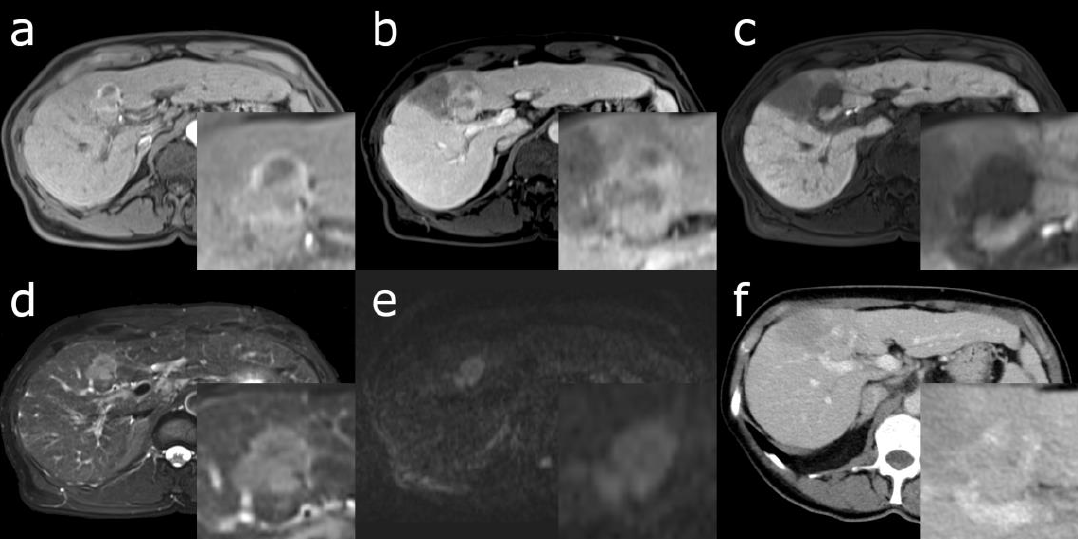
Figure 1. 52-year-old female with liver cirrhosis secondary to chronic hepatitis C infection, Child- Pugh grade A. Axial Gd-EOB enhanced MRI of a singular cHCC-CCA in segment IVa with predom- inant HCC histopathology and macrovascular invasion. ( a ) Rim arterial phase hyperenhancement; ( b ) “washout” in portal venous phase with adjacent parenchymal perfusion deficits; ( c ) homogenous Gd-EOB uptake deficiency in hepatobiliary phase; ( d ) hyperintensity and nodule-in-nodule appearance in a T2-weighted image with fat saturation; ( e ) homogenous diffusion restriction in diffusion weighted imaging (B-value 800); ( f ) CE-CT from the same day showing rim enhancement in the venous phase.